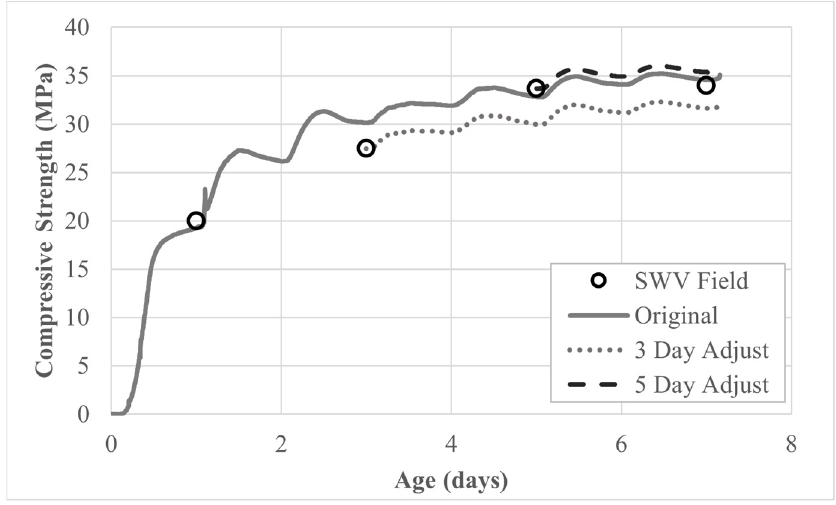
Figure 6. Adjusting the strength gain rate in accordance with field SWV measurements.